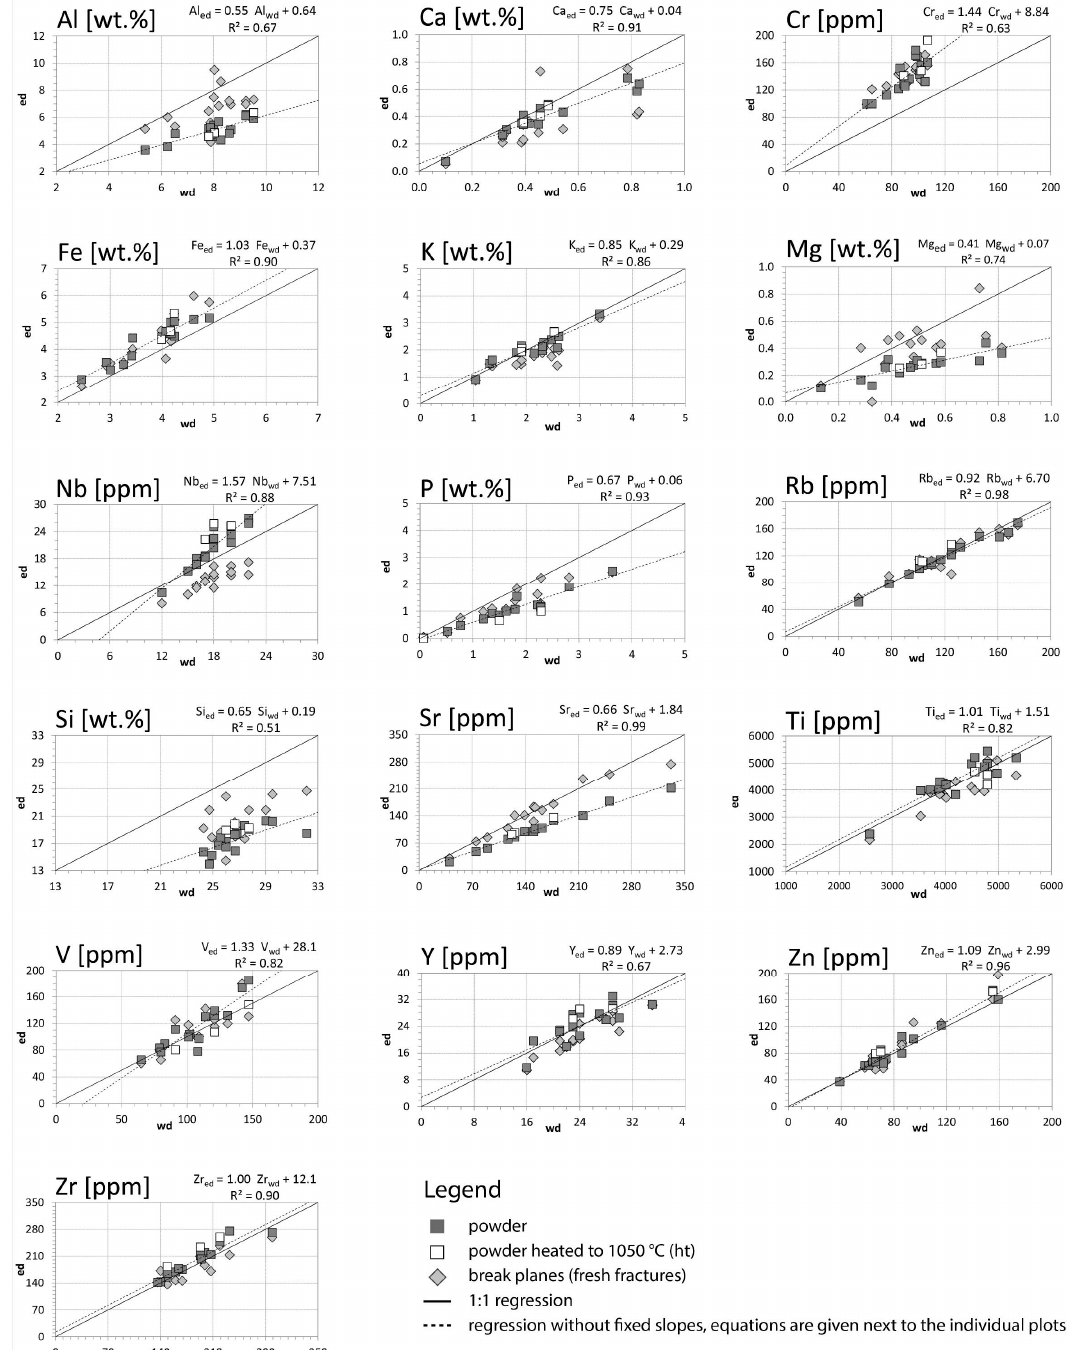
Figure 5. Comparison of portable XRF and WD-XRF measurements. All chemical data are available as a supplementary file (Table S1).